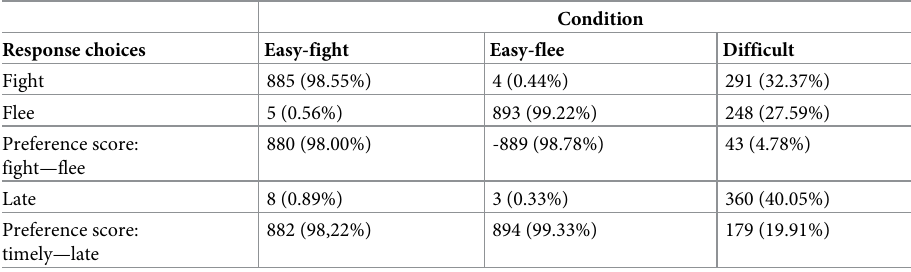
Table 1. Frequencies (and percentages) of response choices and preference